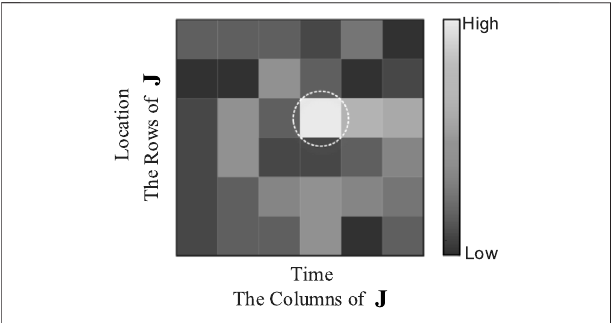
FIGURE 5 | Schematic diagram for event localization. The maximum entry of input-output Jacobian of INN is utilized to locate the event